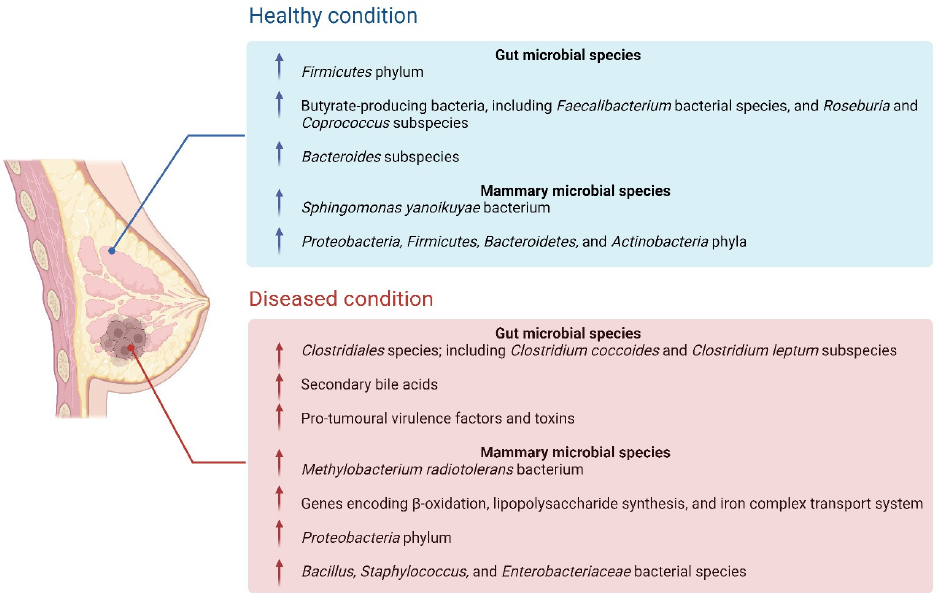
Figure 4. The differences in gut microbiota and mammary microbiota present in healthy individuals, in comparison to a diseased (cancerous) state. This includes increases or decreases in the abundance of protective or pro-tumoural bacterial species and subspecies between the two states.